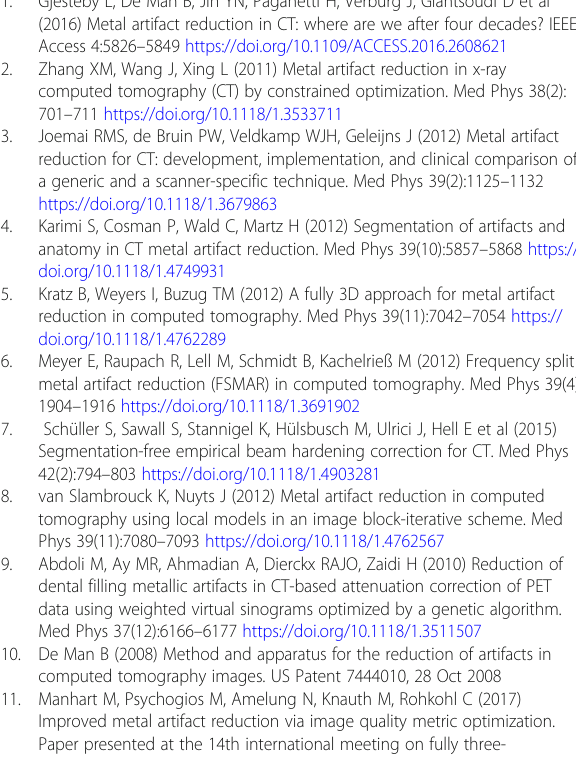
replaced by zeros.